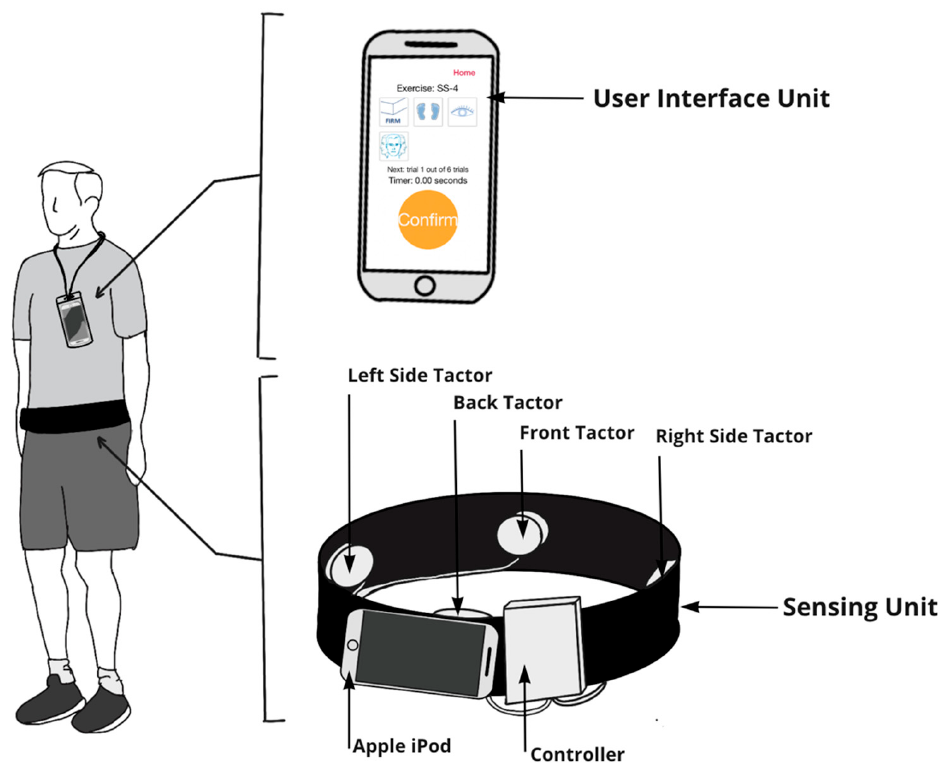
Figure 2. The smartphone-based balance trainer included a user interface unit (Apple iPod) and sensing unit (elastic band with a sensing Apple iPod and four tactors to provide vibrotactile SA). Participants were instructed to wear the user interface unit on a lanyard while performing exercises. participants to start and stop exercises. The sensing unit used (1) the tri-axial gyroscopes embedded in the Apple iPod to measure ML and AP angular velocities, (2) both the tri-axial accelerometers